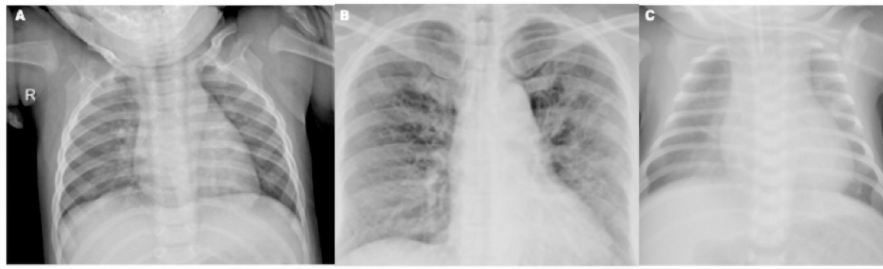
Fig 1. Chest x-ray images: (A) normal; (B) COVID-19 positive; (C) viral